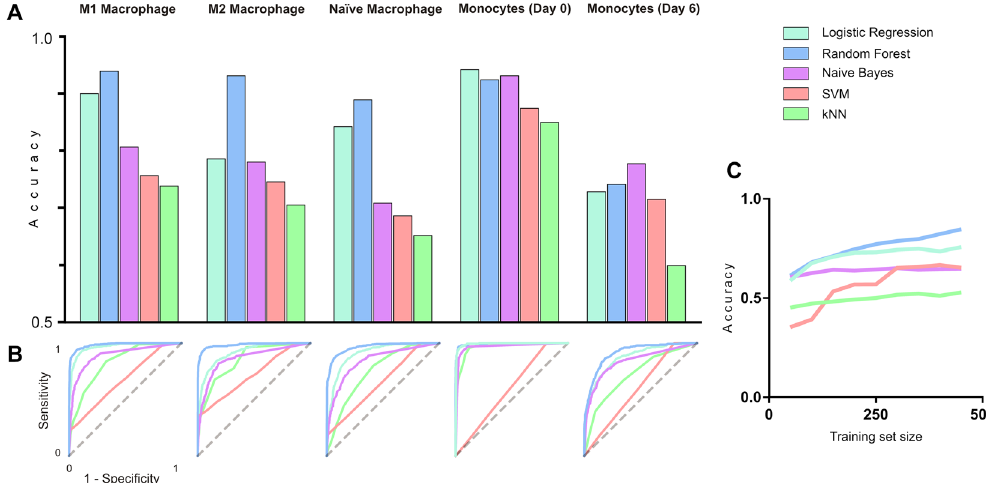
Figure 6. Comparing classifier accuracy in determining M1 and M2 phenotype. ( A ) Classification accuracy of 5 immune cell types using 5 classifiers assessed by 10-fold cross validation. Logistic regression and random forest classifiers showed the highest accuracy for all cell types whilst support vector machine (SVM) and k-nearest neighbours (kNN) frequently misclassified cells. ( B ) ROC curves are plotted for each cell type as classifier sensitivity versus 1-specificity show the variation in classifier performance for each cell type. Dashed grey lines indicate a random guess. ( C ) The influence of training set size on the performance each classifier – accuracy is presented as an average of 10-fold cross validation across each cell